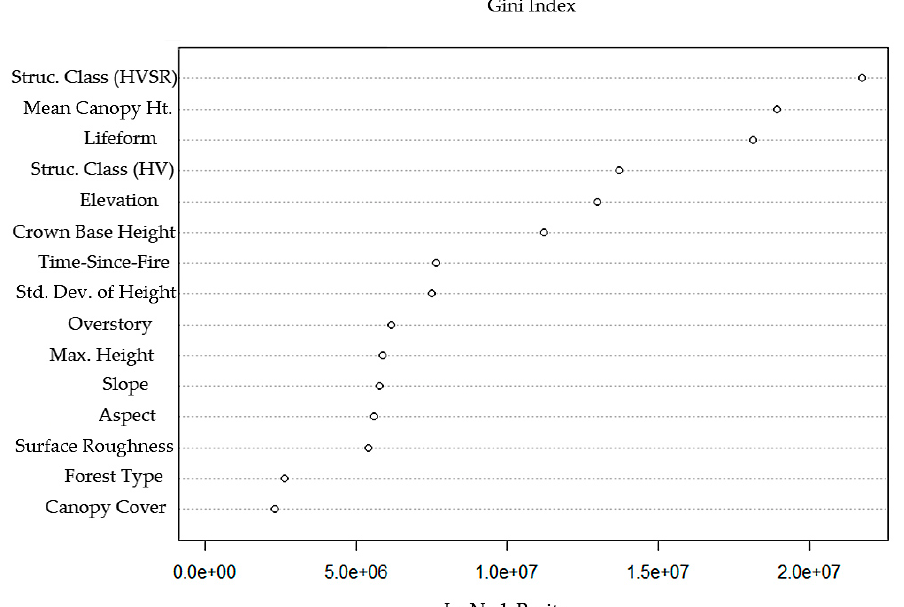
Figure 5. Structure classes on the North Rim of the Grand Canyon. Classes 321 and 322 are dominant on the lower elevation peninsulas. Areas that are dominated by post high severity aspen stand out as class 313. Grassy areas are all classified as 111.